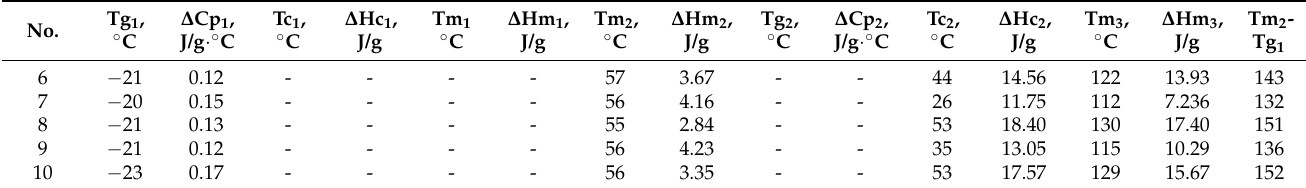
Table A2. Thermal properties of the TPEs of series II.